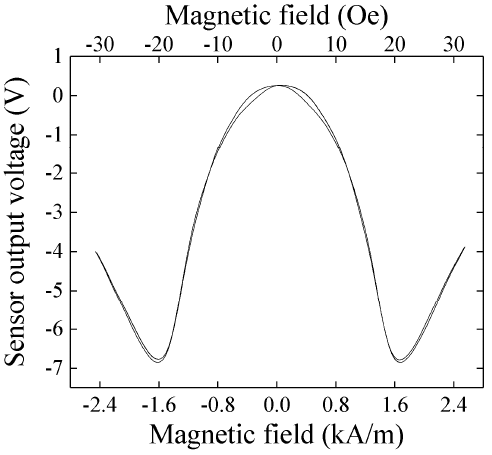
Figure 7. Result of sensor impedance measurement by the circuit.